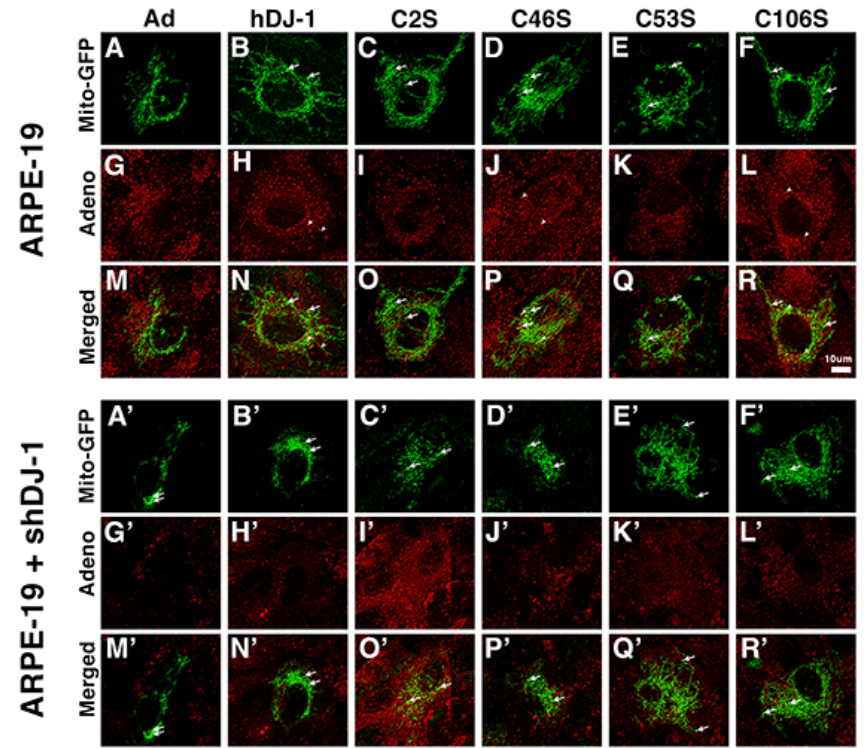
Figure 4. Transduction of several DJ-1 constructs in ARPE-19 monolayers under baseline conditions induces morphological changes in the mitochondria. ( A – R ) ARPE-19 and ( A’ – R’ ) ARPE-19 + shDJ-1 monolayers infected with CellLight ® mito-GFP (green, ( A – F and A’ – F’ ), transduced with the DJ-1 adenovirus constructs and stained with adenovirus type 5 (red) in baseline conditions; arrows = dilated tubules; arrowheads = adenovirus (exogenous DJ-1). Bar = 10 µ m. Post-imaging processing using Lightning was conducted to generate average photon count to better show localization.